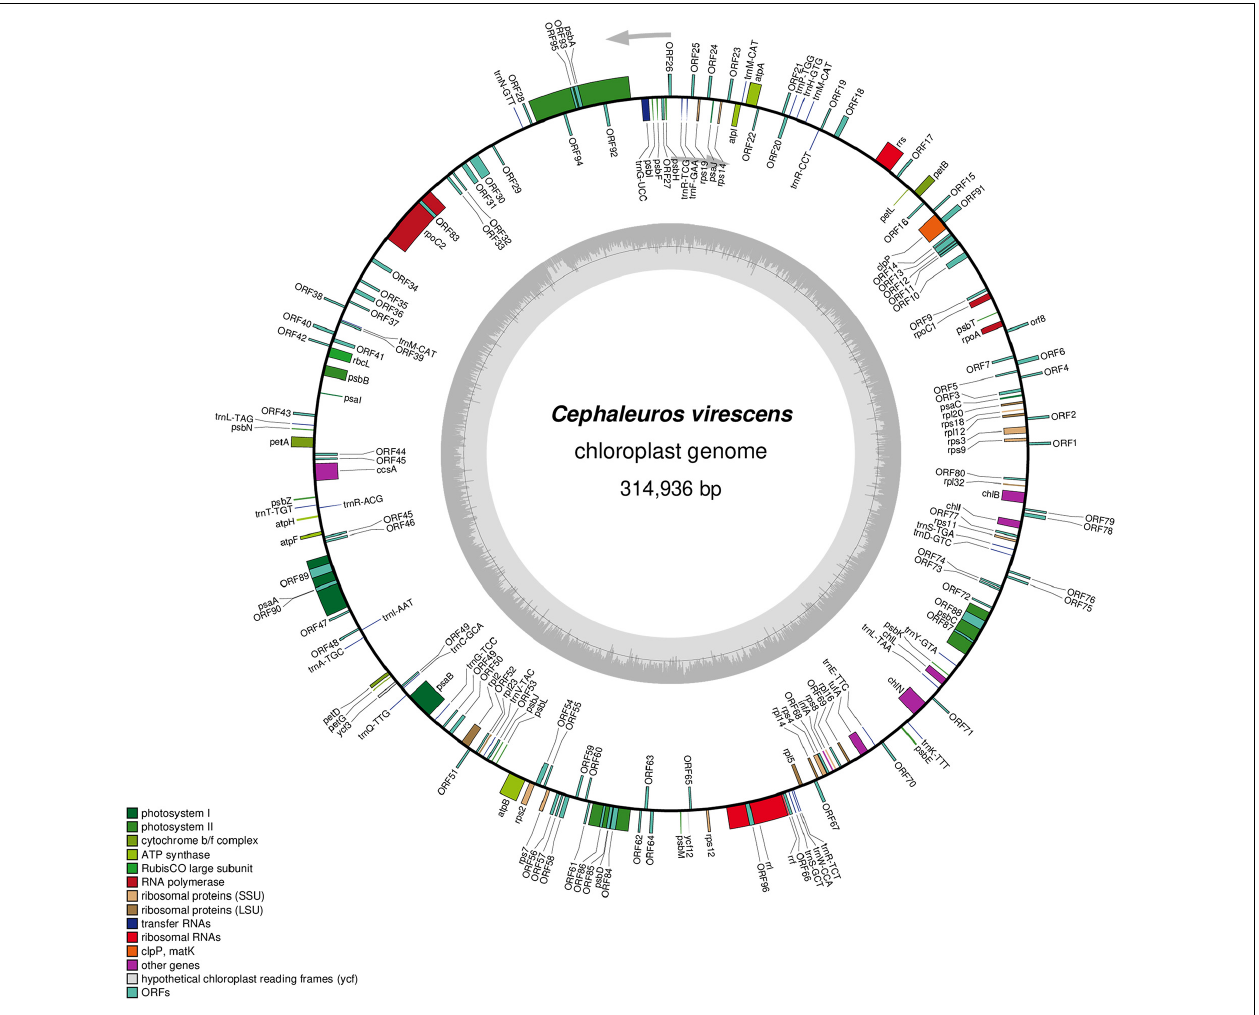
FIGURE 1 | Gene map of the Cephaleuros virescens chloroplast genome. The gray circle on the inside shows a graph of the GC content. Arrows show the direction of transcription. Genes are color-coded according to the functional categories listed in the legend at the bottom left.